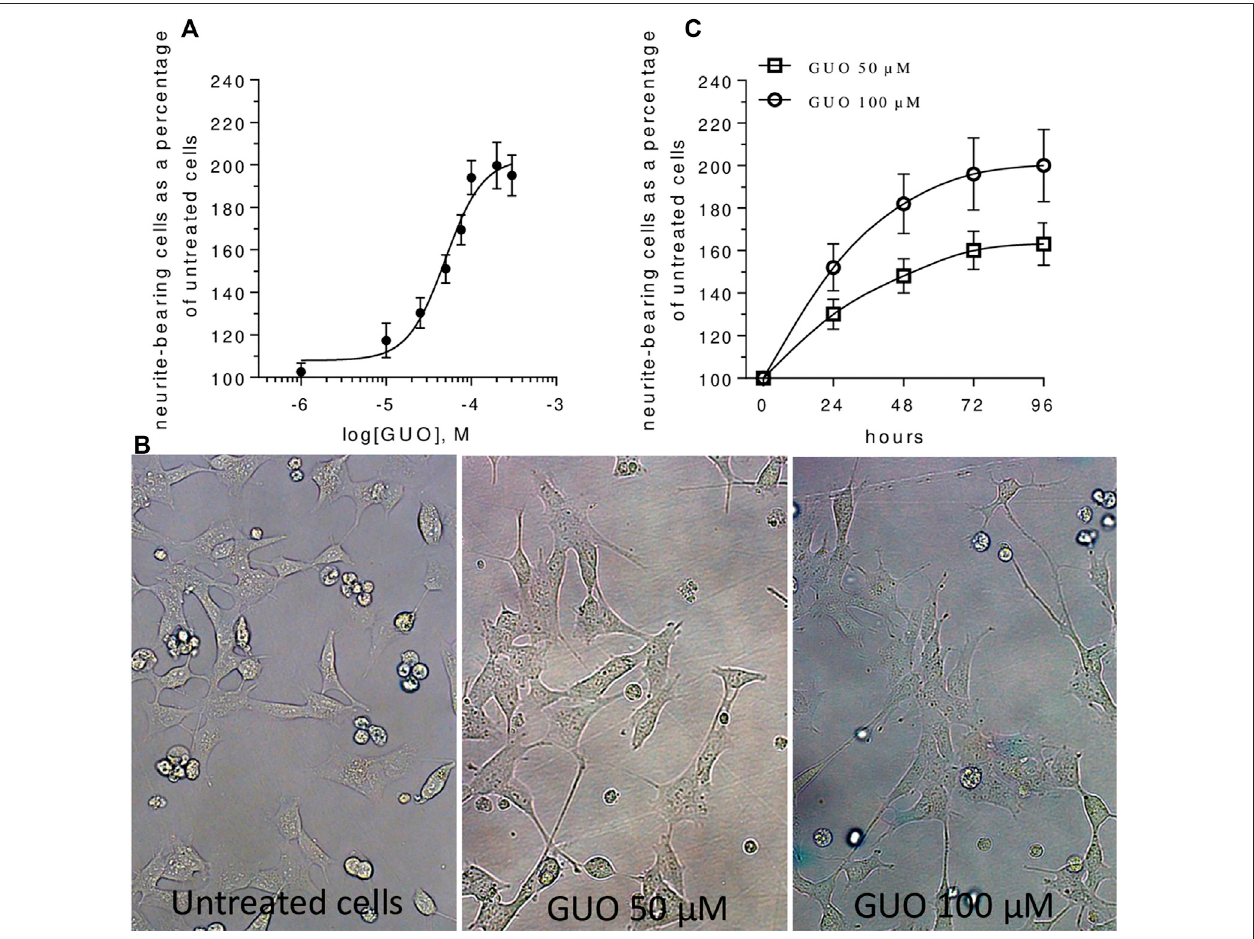
FIGURE 1 | Guanosine induces SH-SY5Y neuroblastoma cell differentiation in a dose- and time-dependent manner. (A) For the concentration-response curve, increasingconcentrations(1 – 300 µM)ofGUOwereaddedfor48 hinmedium containing1%FBS.Anon-linearregressionanalysiswasperformedandEmaxandEC50 were calculated. (B) Representative images of SH-SY5Y cells cultures treated with 0, 50, and 100 μ M GUO in medium with 1% FBS after 48 h. (C) For the time- dependent curve, cell cultures were incubated with GUO (50 – 100 µM) for different times (0 – 96 h) in amedium culture containing 1% FBS. In all cases, the number ofdifferentiatedcells,de fi nedascellshavingneuritesmorethanonecellbodylength,wasdeterminedusingauprightZeissAxiovert200microscope,totalmagni fi cation 200x (Zeiss, Jena, Germany). Values are expressed as a percentage of neurite-bearing cells vs untreated cells and represent the mean ± SEM from at least three to fi ve independent experiments.